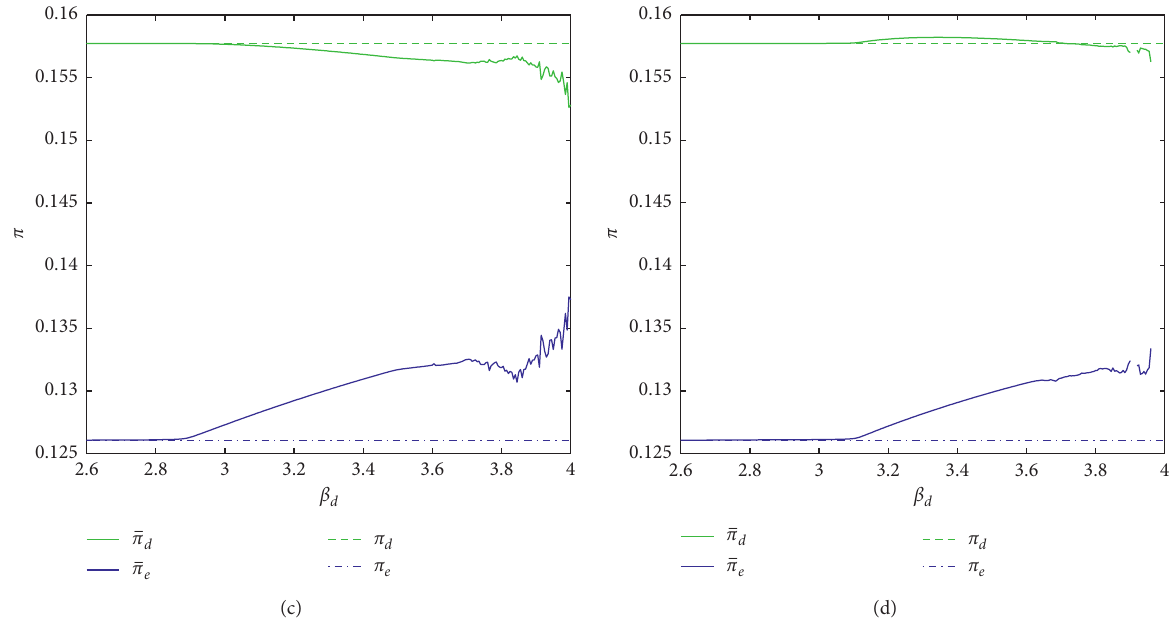
Figure 9: Impacts of β